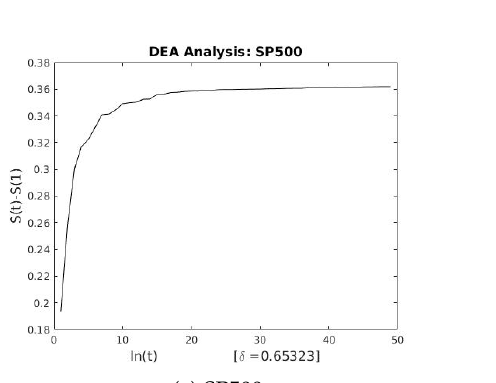
Figure A5. DEA for PSI and SETI.